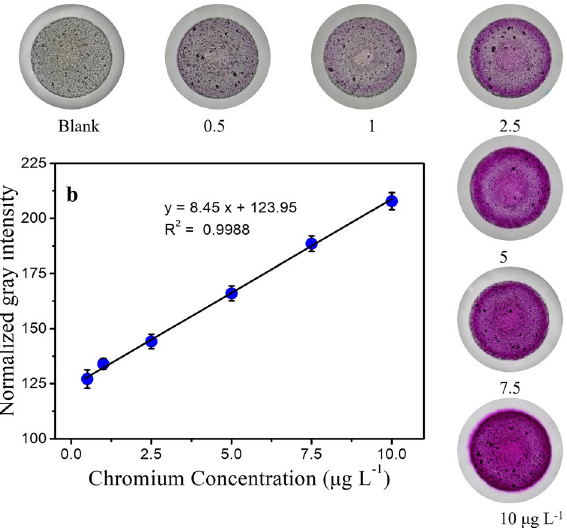
Figure 5. Chromium(VI) ions detection using adsorptive colorimetric method ( a ) Image of adsorbent with different concentration of Cr(VI) ions for the optimized adsorption conditions. ( b ) Linear calibration plot in the range of 0.5–10 µg L −1 obtained by measuring normalized gray intensity.